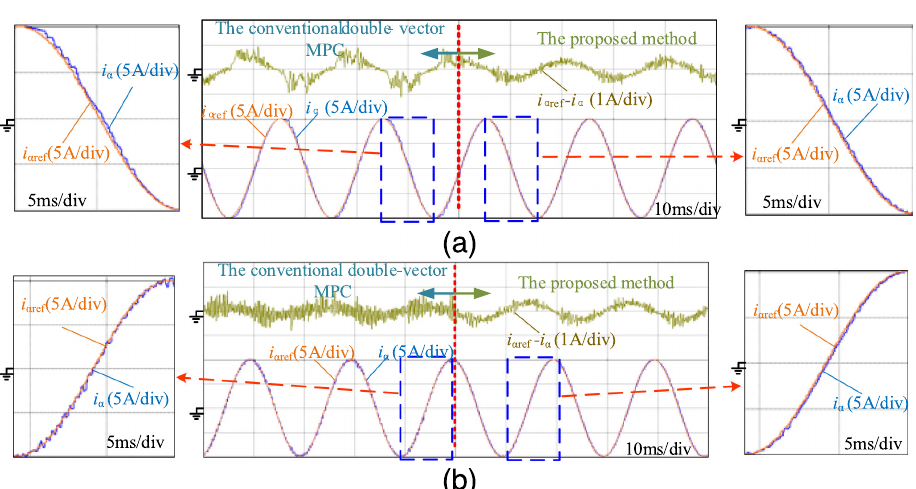
Fig. 16. Comparison of current THD and ripple when the reference current is 10 A with the filter inductance set as 0.01 H. (a) Conventional double-vector MPC. (b) Proposed method.